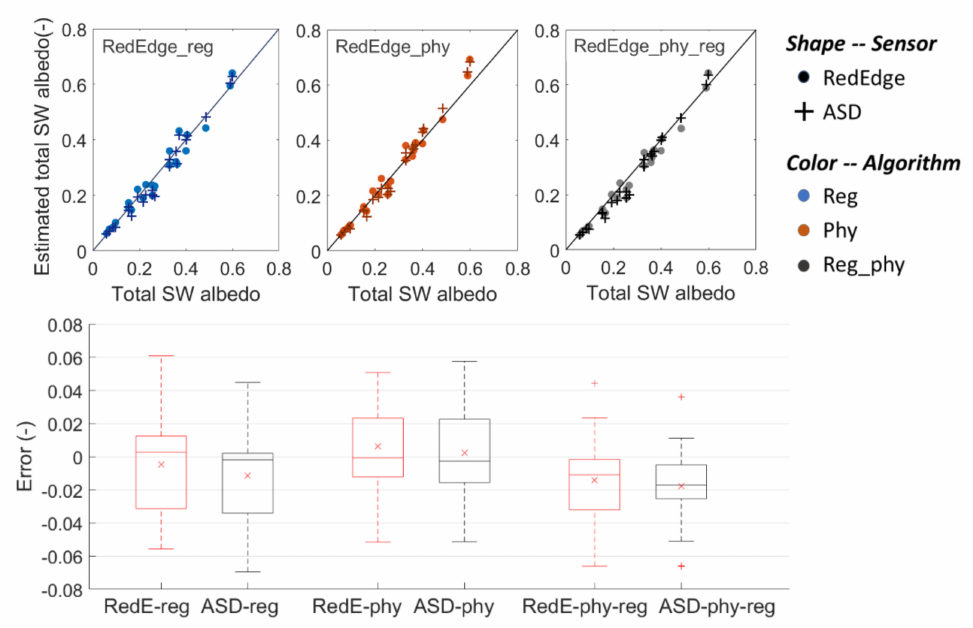
Figure 9. Di ff erence between the narrowband albedos derived from RedEdge multispectral images and ASD measurement.